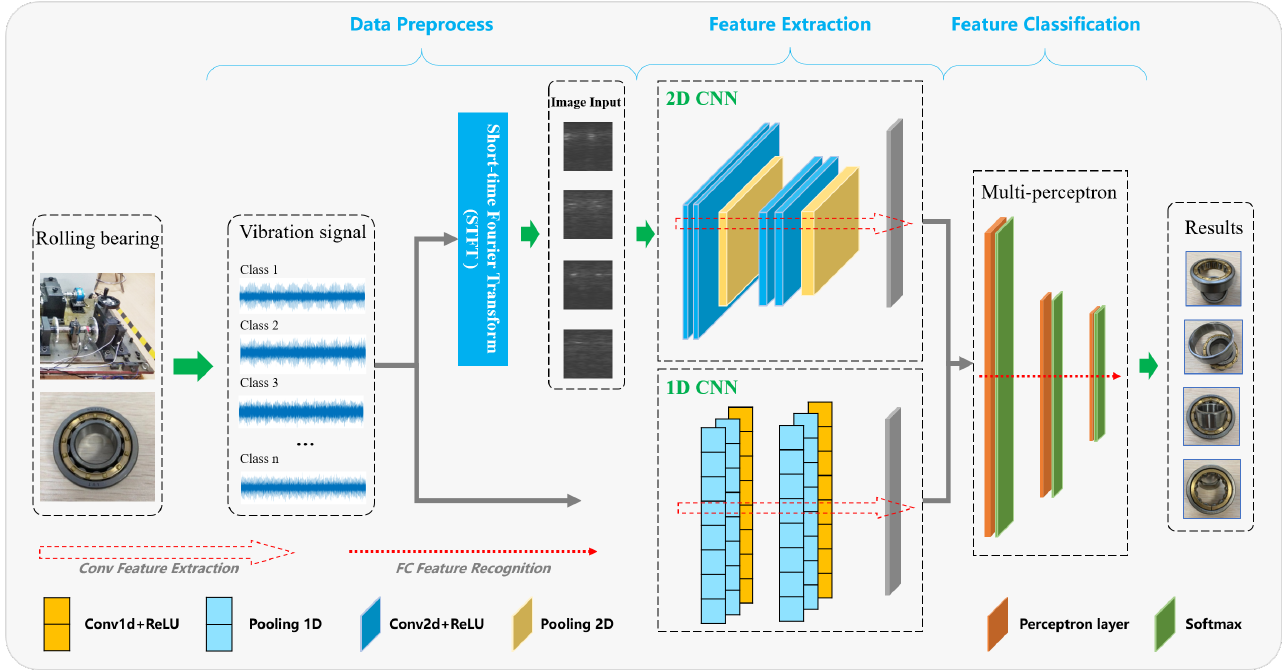
Figure 2. The proposed method of this paper.